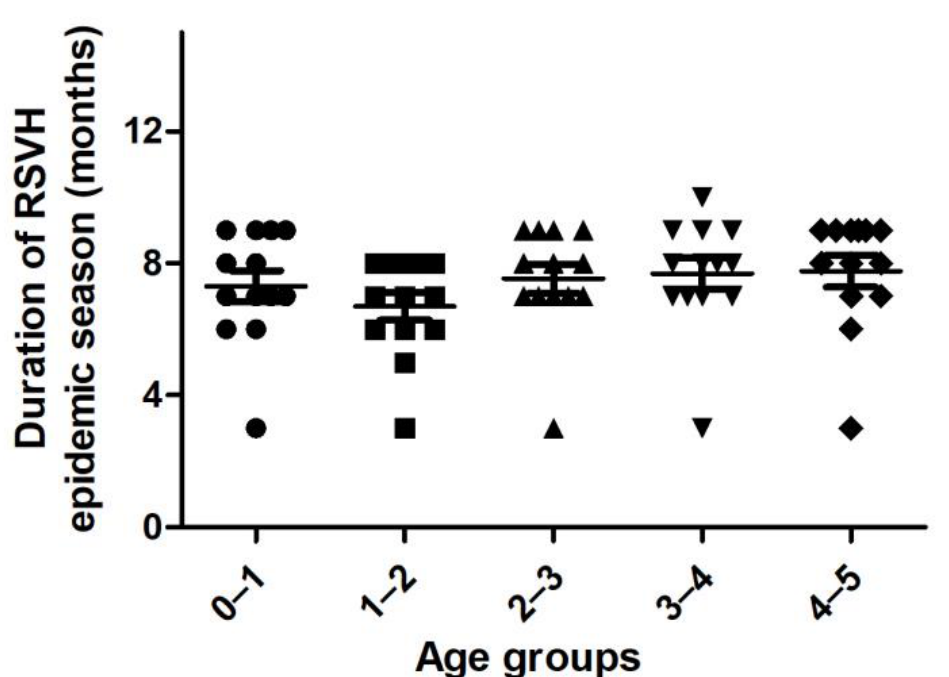
Figure 4. The duration of RSV epidemic season in Taiwan. The RSVH AAP was calculated by monthly RSVH number in index year divided by annual RSVH number in index year. The minimum number of months to accumulate for total AAP to reach 75% was estimated as the RSV epidemic season. The duration of RSV epidemic season in different-aged children was calculated for each year. The symbols indicated that the duration of RSV epidemic season among 0–5-year-old children in 2008-2020.